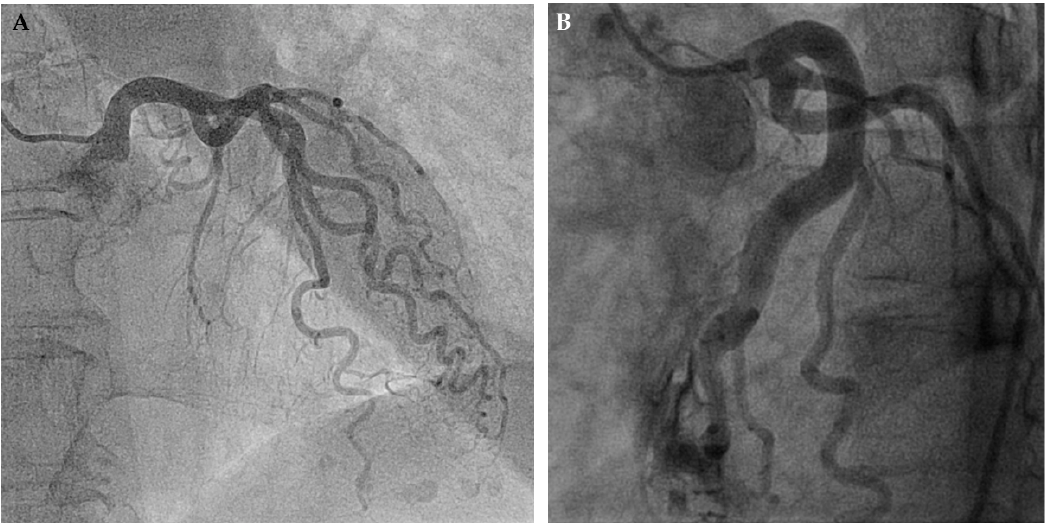
Figure 4. Angiographic presentation of two different pathophysiological etiologies of arteriogenesis. ( A ) Arteriogenesis in the course of hypertensive heart disease with concentric left ventricular hypertrophy. Enlarged myocardial mass is the driving force behind this arterial growth. ( B ) Arteriogenesis solely initiated by constant elevation of fluid shear stress. Iatrogenic drainage of the left anterior descending artery (LAD) into the right ventricular cavity after myocardial biopsy significantly increased coronary blood flow and consequently vascular size.